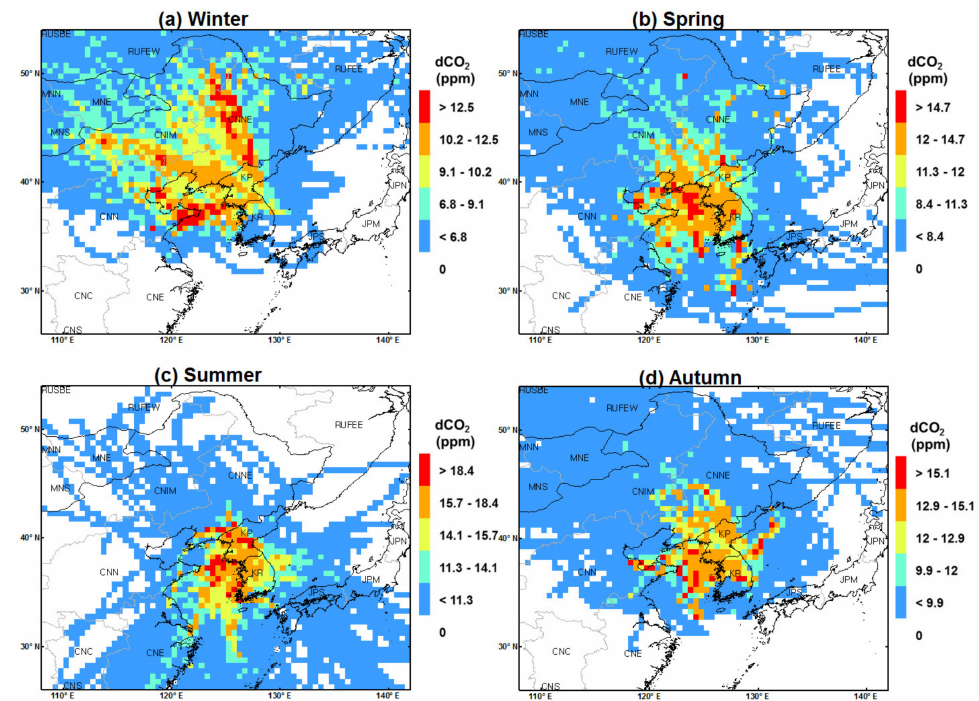
Figure 7. CO 2 source distribution map derived by CWT analysis for ( a ) winter, ( b ) spring, ( c ) summer, and ( d ) autumn. Each gridded map value denotes the trajectory residence time weighted average of the dCO 2 values.